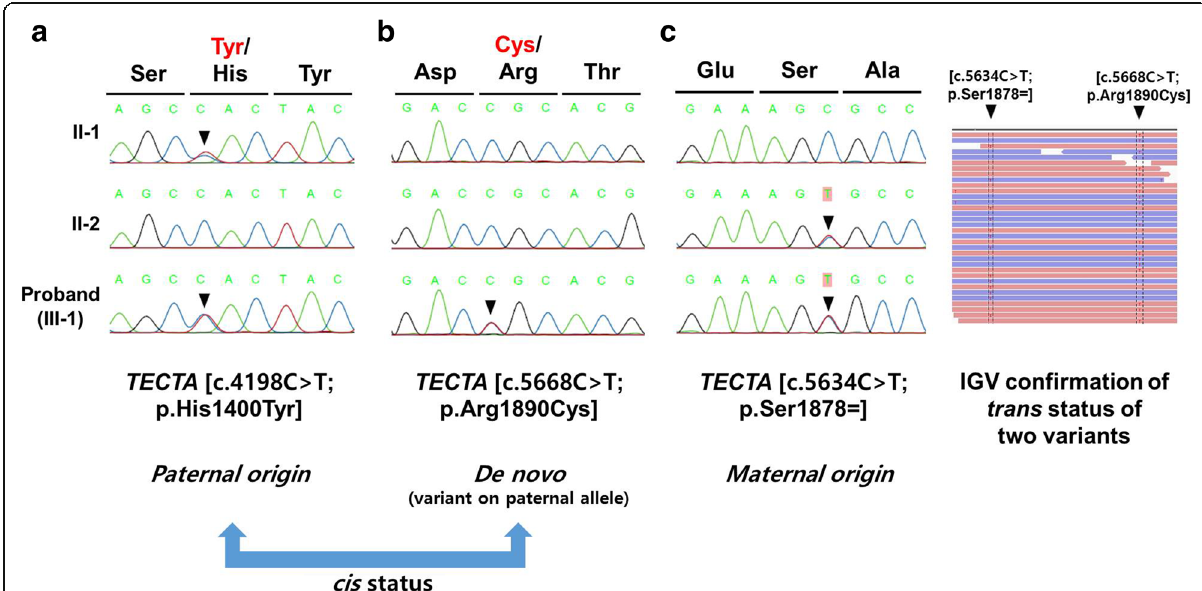
Fig. 2 Electropherograms for the family YUHL-165 showing the heterozygous R1890C and H1400Y mutations of TECTA in the proband and only the H1400Y mutation in the father. a Segregation of the TECTA gene showing the H1400Y substitution. b Segregation of the TECTA gene showing the R1890C substitution. c Use of synonymous variant in the TECTA gene for cis/trans status determination of the two missense